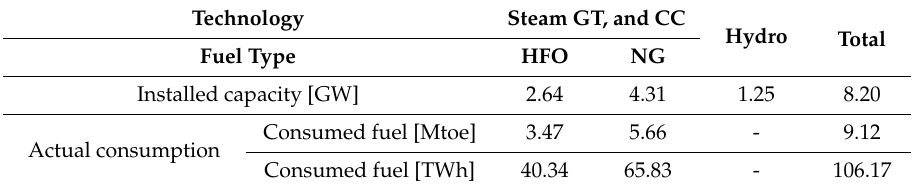
Table 10. Available installed capacity by technology and actual fuel consumption of the SEPS in 2010.